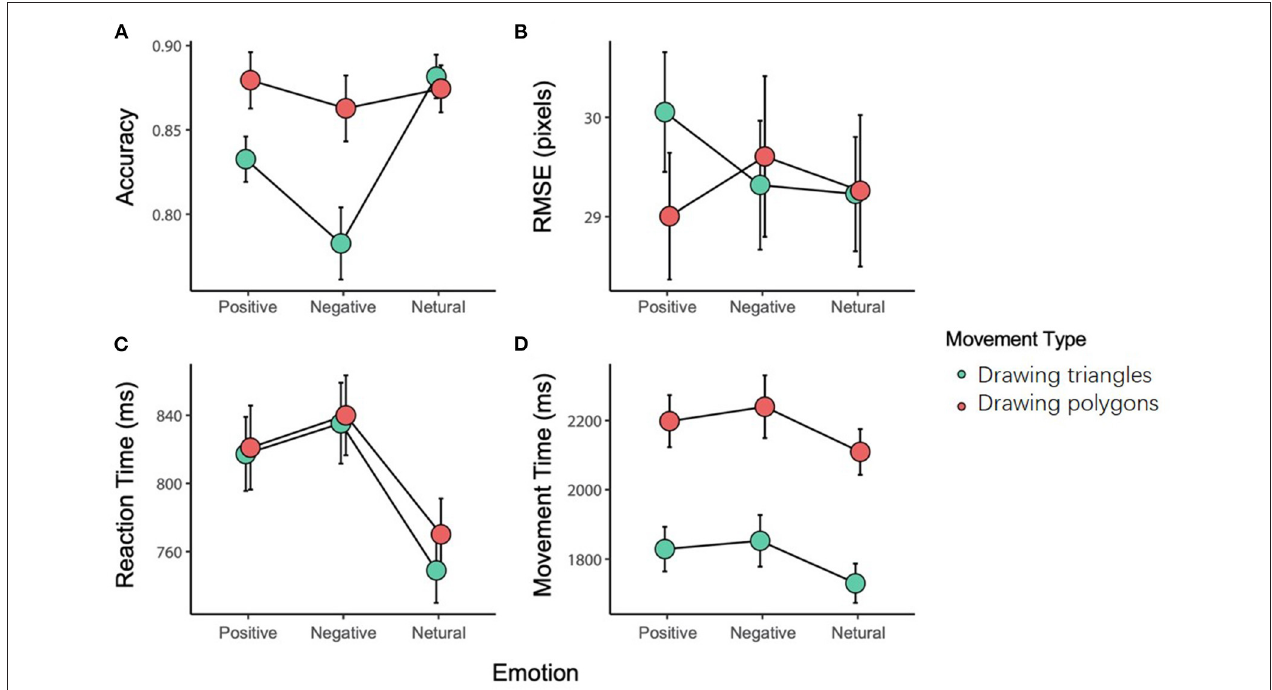
FIGURE 2 | The results of the variables [( A) accuracy, (B) RMSE, (C) reaction time, (D) movement